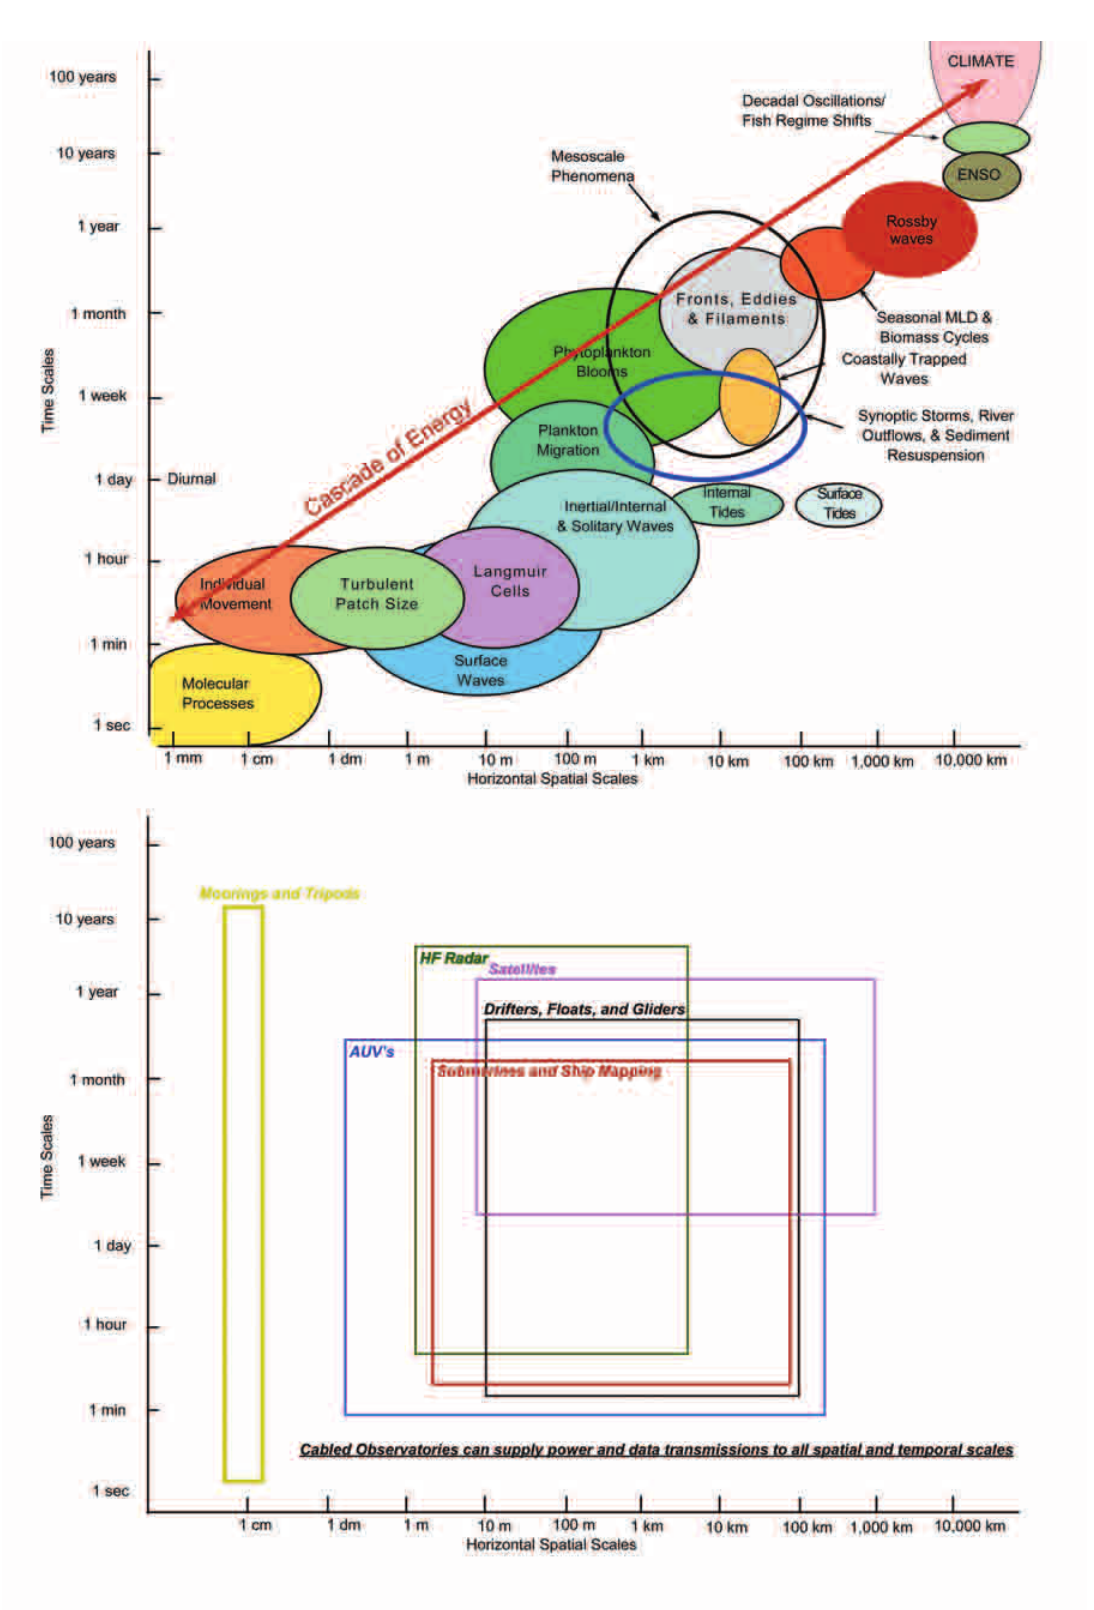
F IG . 1. – Time and horizontal space plot indicating a variety of ocean processes (top) along with rough coverage domains of various oceano- graphic platforms (bottom). The arrows on the figure are intended to draw attention to the cascade of energy and information from large to small scales as well as small to large